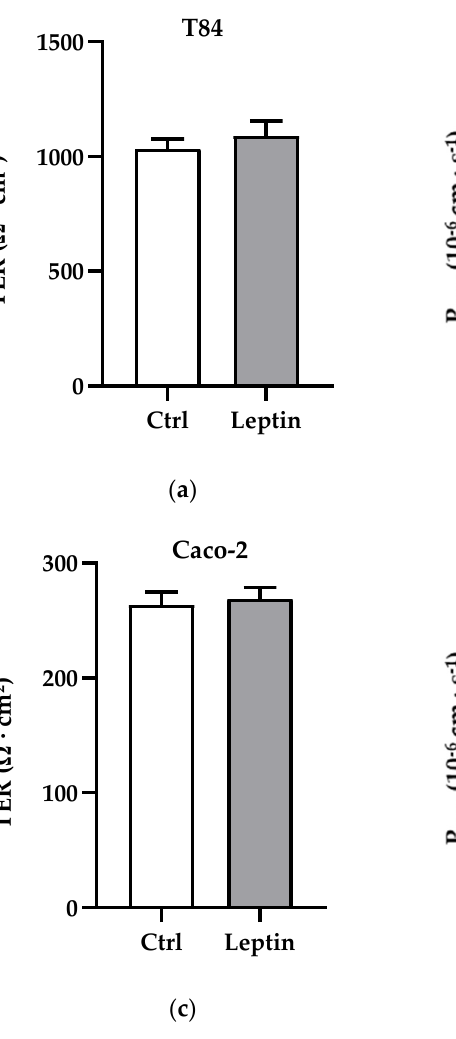
Figure 5. Functional analysis in T84 and Caco-2 cells. ( a ) Transepithelial resistance (TER) in T84 cells. ( b ) Permeability for FITC-dextran 4 kDa (P FD4 ) in T84 cells: Ctrl = 0.075 ± 0.005 × 10 − 6 cm · s − 1 , n = 9; leptin = 0.086 ± 0.010 × 10 − 6 cm · s − 1 , n = 8. ( c ) Transepithelial resistance in T84 cells. ( d ) Permeability for FITC-dextran 4 kDa in Caco-2 cells: Ctrl = 0.045 ± 0.008 × 10 − 6 cm · s − 1 , n = 9; leptin = 0.083 ± 0.016 × 10 − 6 cm · s − 1 , n = 11, * p <